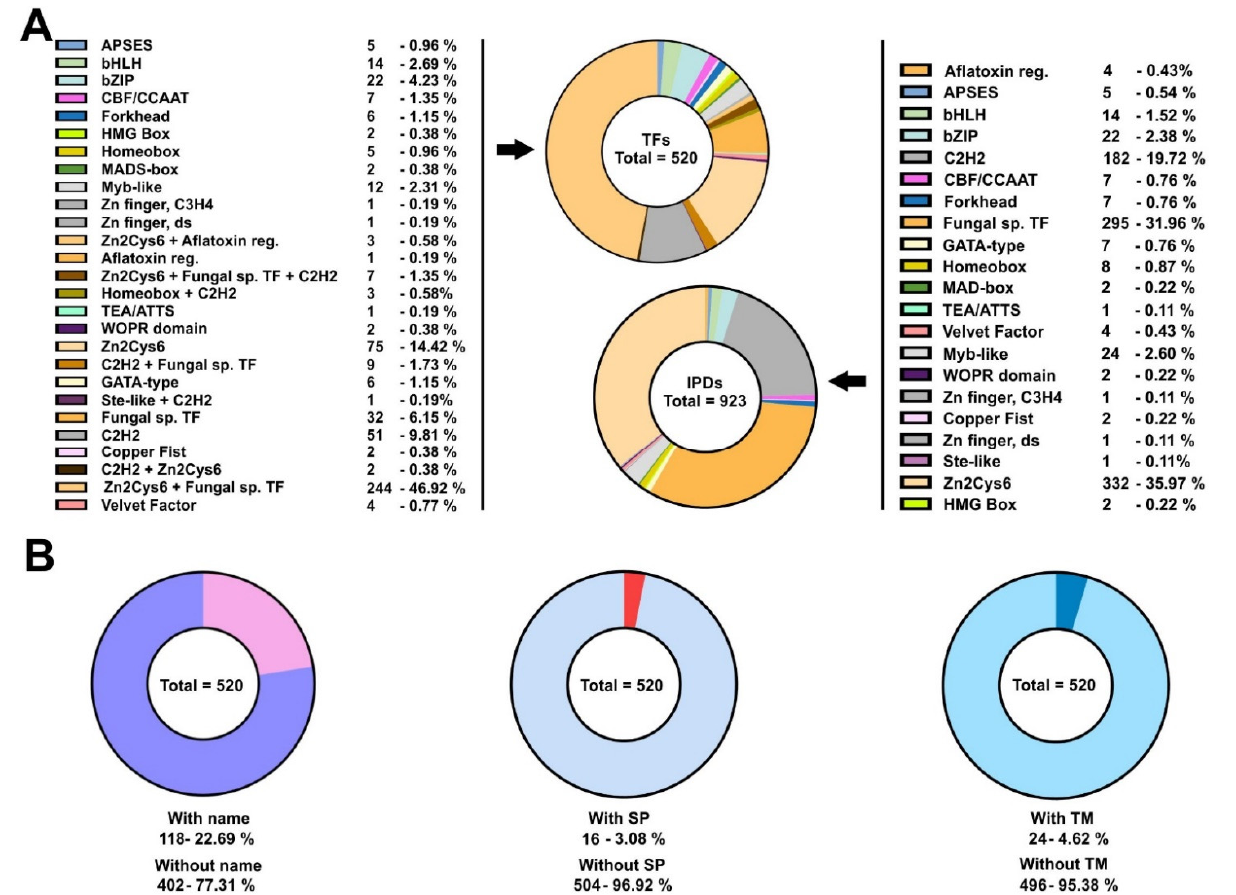
Figure 1. Potential TFome of the model filamentous ascomycete A. nidulans : ( A ) Pie charts showing the number and percentage of TFs (left; of a total of 520) and IPDs (right; of a total of 923) of each family potentially encoded by the genome of A. nidulans . Color keys are included. Both tables are an update of the list published by Wortman and colleagues [14]. ( B ) Pie charts showing the number of genes coding for TFs with a standard name (left), the number of potential TFs predicted to include a signal peptide in their sequences (middle) or those predicted to contain TM domains (right). See also Tables S2–S4.